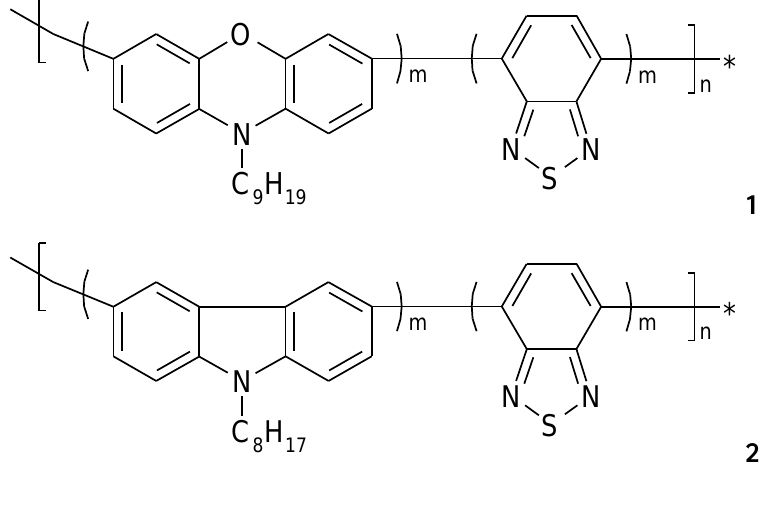
Figure 6. Conjugated polymers—poly[( N -nonylphenoxazine-3,7-diyl- alt -(1,2,3- benzothiadiazole)]— 1 , and poly[( N -octylcarbazole -3,6-diyl- alt -(1,2,3-benzothiadiazole)]— 2